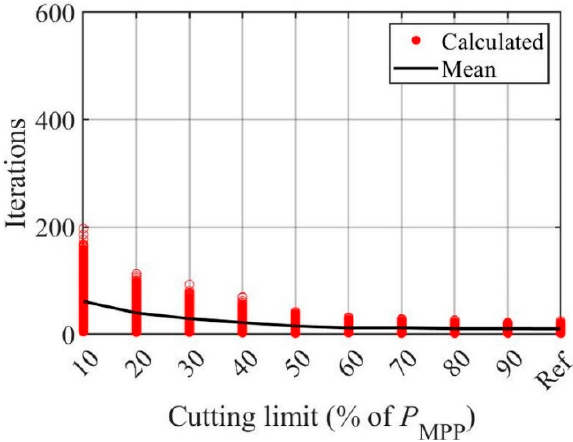
Figure 10. Iterations needed for fitting during the 40 min measurement period as a function of the cutting limit based on MPP power.